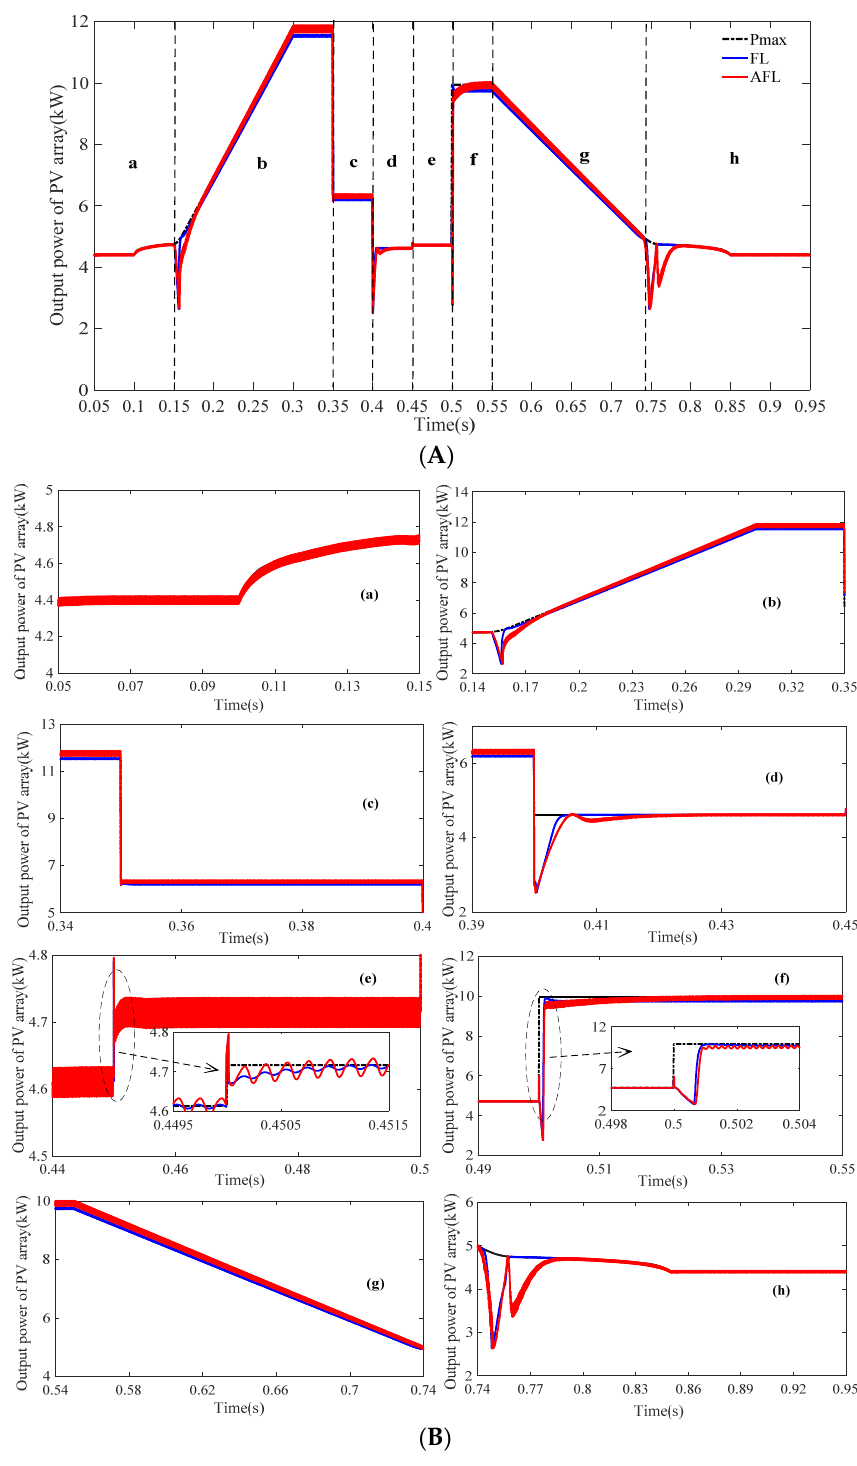
Figure 11. Output power of PV systems with AFL and FL: ( A ) Output power (overall); ( B ) output power (detailed): ( a ) output power (0.05–0.15 s); ( b ) output power (0.15–0.35 s); ( c ) output power (0.35–0.40 s); ( d ) output power (0.40–0.45 s); ( e ) output power (0.45–0.50 s); ( f ) output power (0.50–0.55 s); ( g ) output power (0.55–0.74 s); ( h ) output power (0.74–0.95 s).